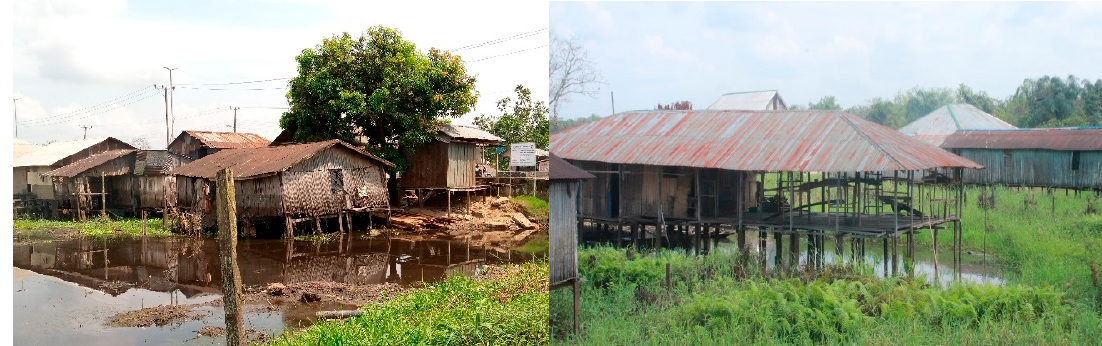
( b ) Figure 1. ( a ) Map showing the location of Igbokoda in the Ilaje local government area and within Ondo State. ( b ) Satellite image showing the broad street axis of Igbokoda where field work was conducted. Dwellings in coastal settlement areas are unique and remarkably different from those on the mainland. Foundations of waterfront dwellings in Igbokoda, like other coastal settlements, are constructed on raised plinths or wooden piles made of ironwood (called omoghen in the local language) (see Figure 2). Ironwood is well known for its durability and strength, reportedly lasting